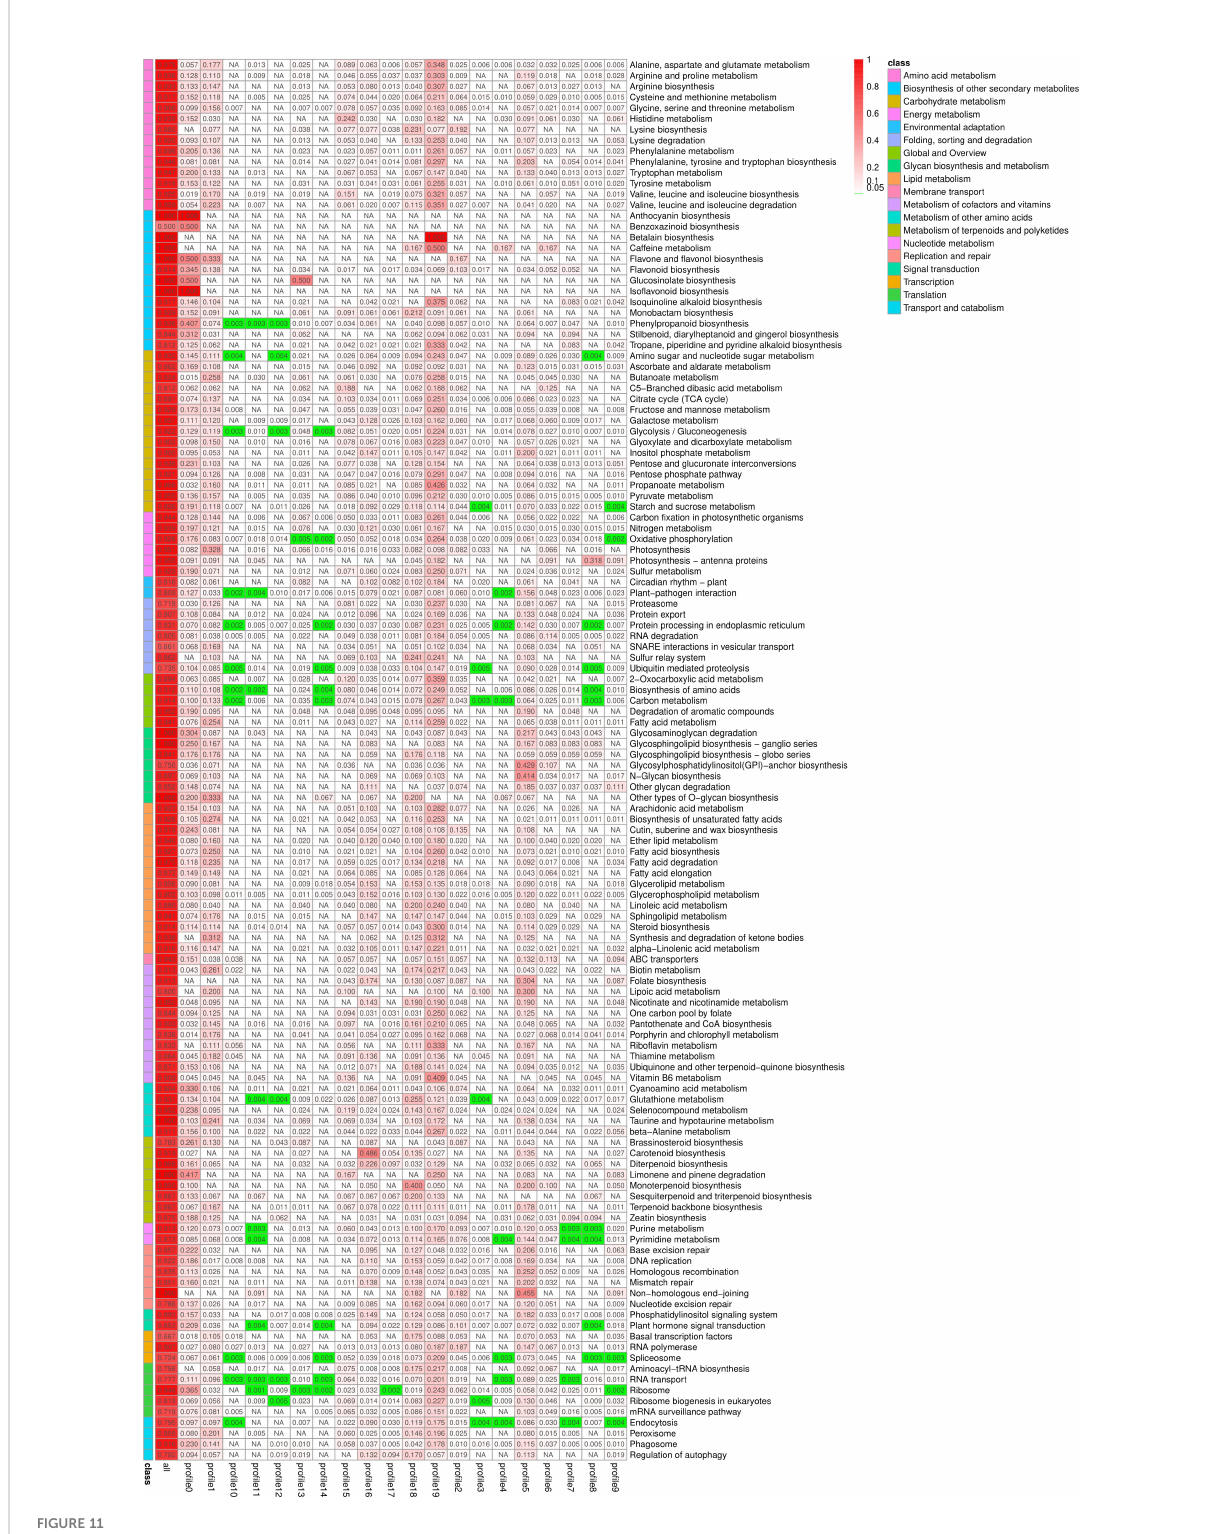
FIGURE 11 Pathway enrichment analysis rich factor heat map. NA, Not